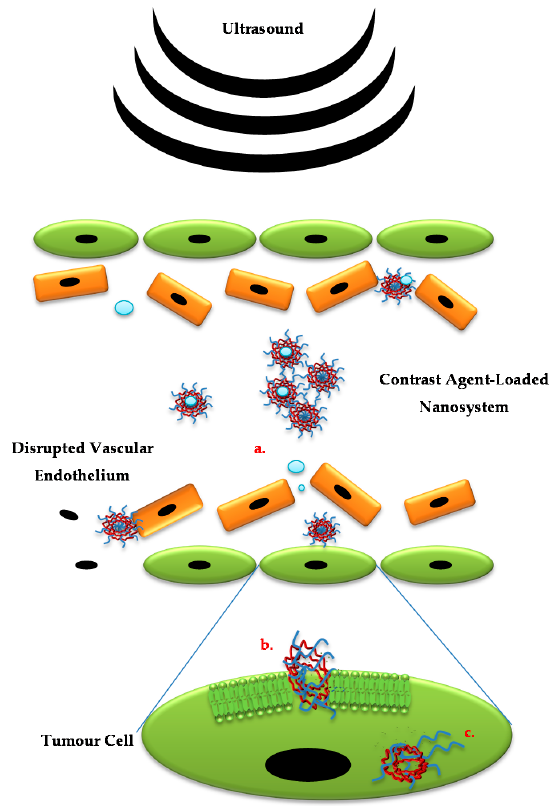
Figure 6. Schematic illustrating various ultrasound-responsive mechanisms: ( a ) Application of focused ultrasound guides nanosystems to the site of action and disrupts vascular endothelial barrier allowing the nanosystem direct access to tumour cells; ( b ) Sonoporation of the tumour cell membrane increases its permeability with possible sonochemical shape change of nanosystem promoting entry into the cell; ( c ) Should the nanosystem incorporate an ultrasound-responsive component, extracellular/intracellular nanosystem disruption with subsequent drug release is also promoted.